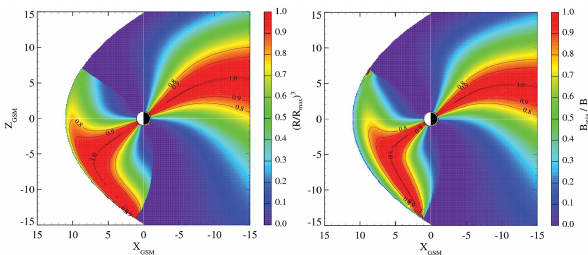
Figure 11. Illustrating the relation between the magnetic field de- pressions and B r reversal areas. Left panel: distribution of δ = R/R max (see text for explanation). Right panel: distribution of the inverse mirror ratio ε = B min /B . Both diagrams were obtained for a vacuum magnetic configuration with a tilted dipole field, shielded within a T96 model magnetopause, and correspond to the noon– midnight meridian plane ( Y GSM = 0).